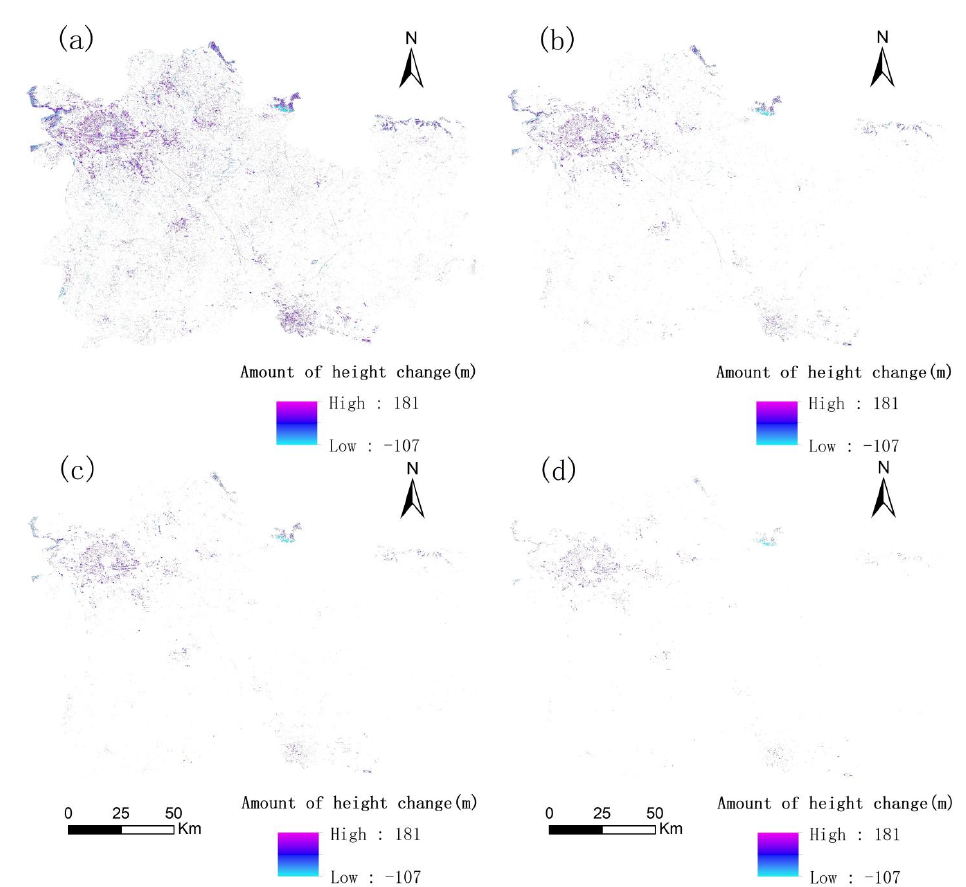
Figure 8. ( a ) Height changes of less than 7 m are excluded; ( b ) Height changes of less than 11 m are excluded; ( c ) Height changes of less than 14 m are excluded; ( d ) Height changes of less than 20 m are excluded.